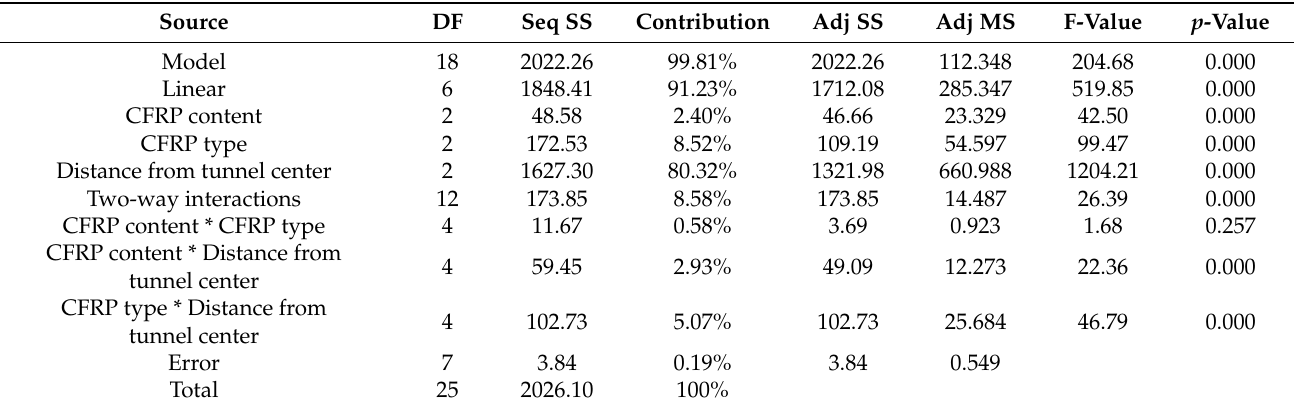
Table 9. Analysis of variance for speed of 60